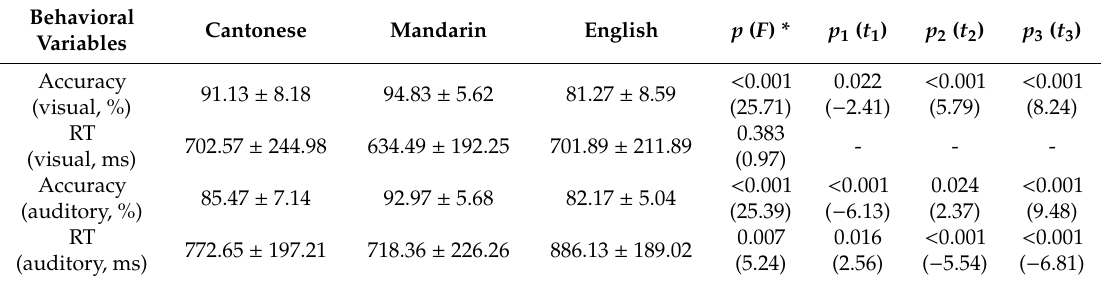
Table 2. Behavioral results of the participants in visual rhyming tasks and auditory